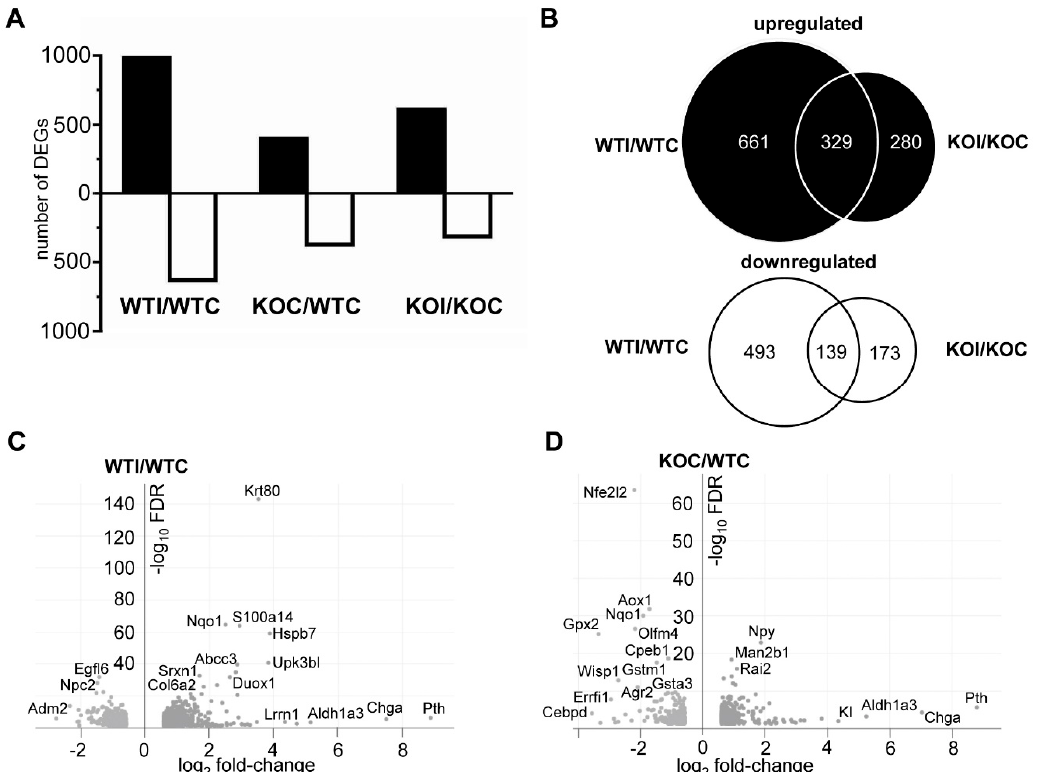
Figure 2. ( A ) Number of di ff erentially expressed genes (DEGs) (messenger RNAs (mRNAs)) per comparison. The e ff ect of iodide on wild-type (WT) mice (WTI / WTC) and on Nrf2 knockout (KO) mice (KOI / KO), as well as the e ff ect of genotype (KOC / WTC) on gene expression, were assessed by the DESeq2 method, with a false discovery rate (FDR) set at 0.05 and the minimum gene expression fold change set at 1.5. Table S2 (Supplementary Materials) contains full lists of DEGs. ( B ) Venn diagrams with upregulated and downregulated genes (mRNAs) after iodide in WT and Nrf2 KO mice. ( C ) Volcano plots of genes that are di ff erentially expressed (FDR < 0.05, fold change ≥ 1.5) in WT mice after iodide (WTI / WTC). ( D ) Volcano plots of genes that are di ff erentially expressed (FDR < 0.05, fold change ≥ 1.5) in Nrf2 KO mice versus WT mice (KOC / WTC) without excess iodide. Some gene names are indicatively